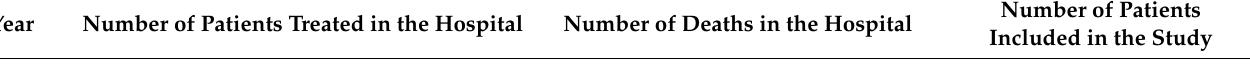
Figure 4. Dilated cardiomyopathy. ( A , B )—macroscopic aspect, ( C )—myocarditis: hematoxylin–eo-